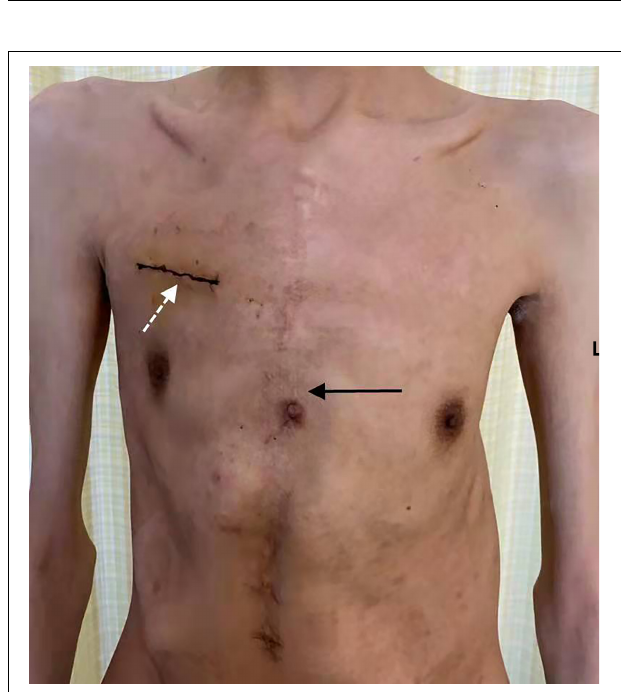
FIGURE 3 | Skin incision. The image shows a skin incision in the right minithoracotomy Bentall procedure (where the white dotted arrow is pointing) and a skin incision in previous mitral valve repair via full median sternotomy (where the black arrow with a solid line is